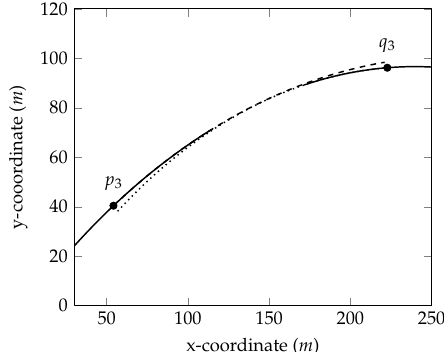
Figure 4. The three entry points for the blending spline transition curve on the circular segments.